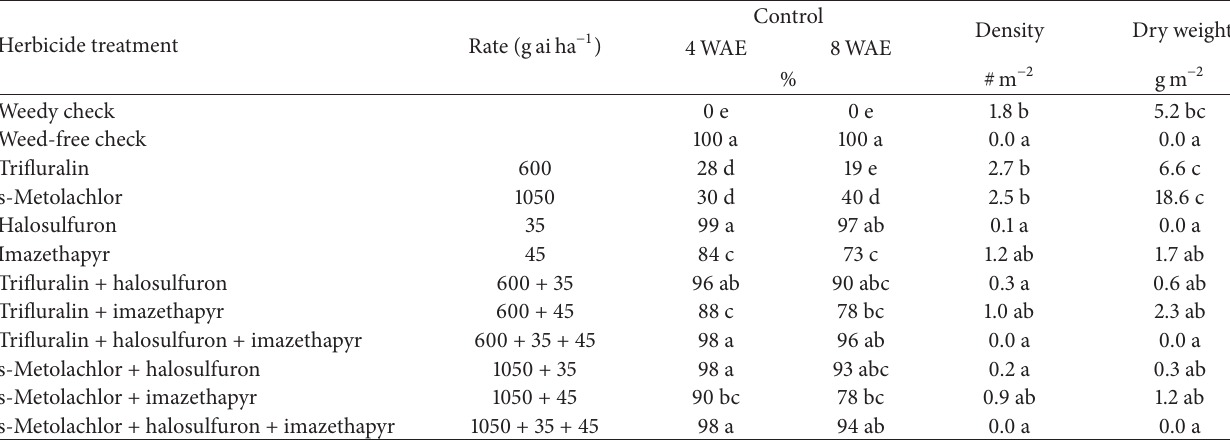
Table 3: Percent control, density, and dry weight of common ragweed in white bean treated with halosulfuron tankmixes applied PPI at Exeter, ON (2012-2013). Means followed by the same letter within a column are not significantly different according to Fisher’s Protected LSD at 𝑃 < 0.05 a .